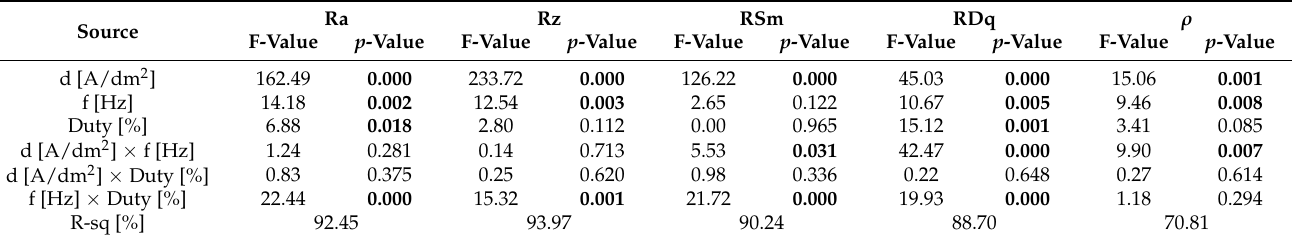
Table 7. Anova results in terms of p -value and F-value.